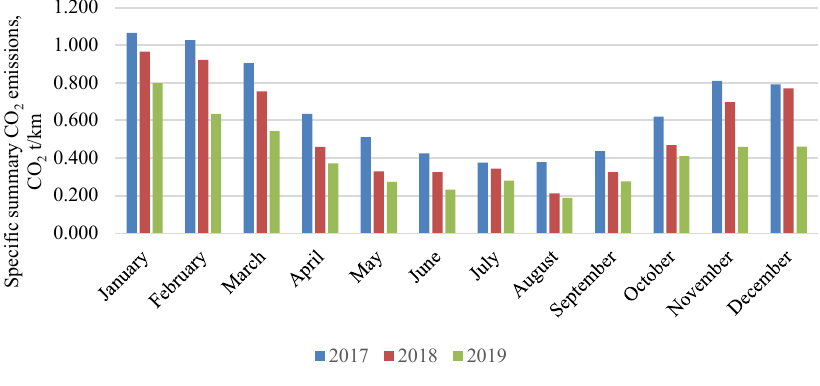
Fig. 3. Specific total CO 2 emissions over three